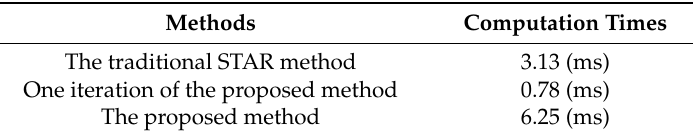
Table 3. The Computation Times of the Two Methods.